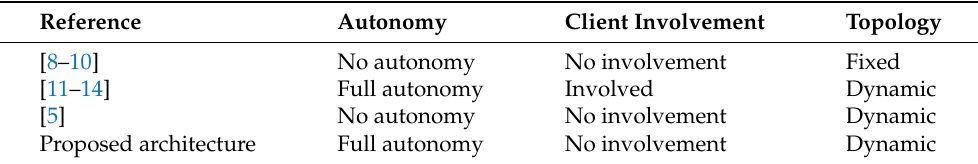
Table 1. Related work summary and comparison with the proposed